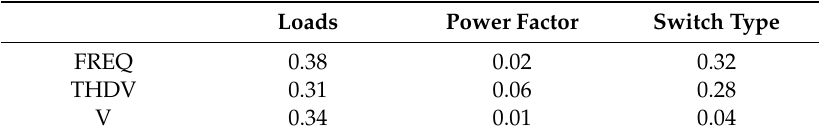
Table 9. Mutual information estimated among the appliance features and cluster labels derived from PQ parameters measured at SoC